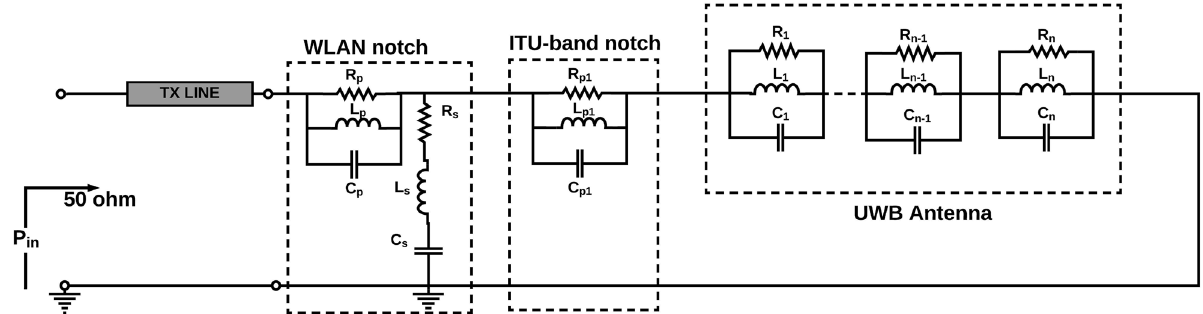
Figure 8. The lumped equivalent circuit model of WLAN and ITU (8 GHz) band notch filter.